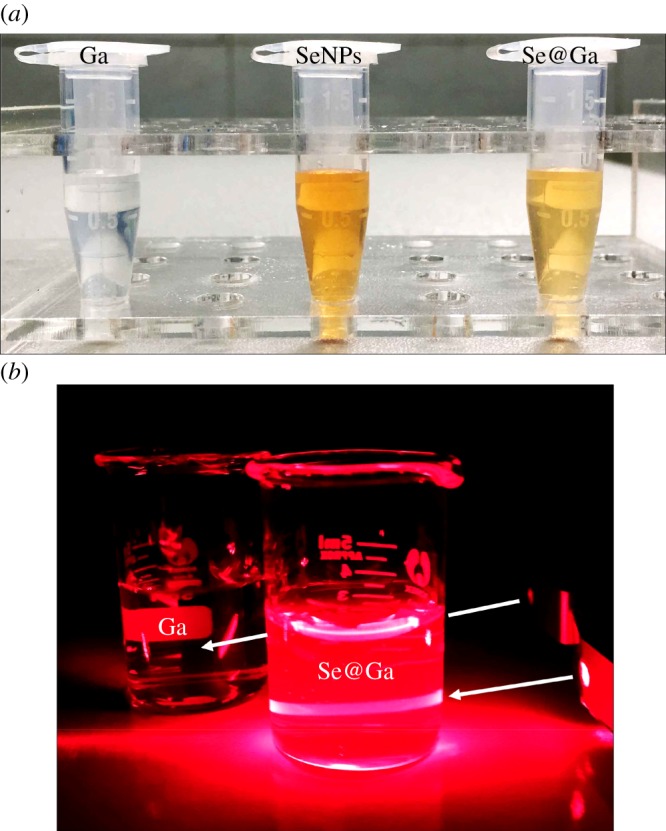
Light image of Ga, SeNPs and Se@Ga. (a) The colour change of Ga, SeNPs and Se@Ga. (b) Tyndall effect of Se@Ga.